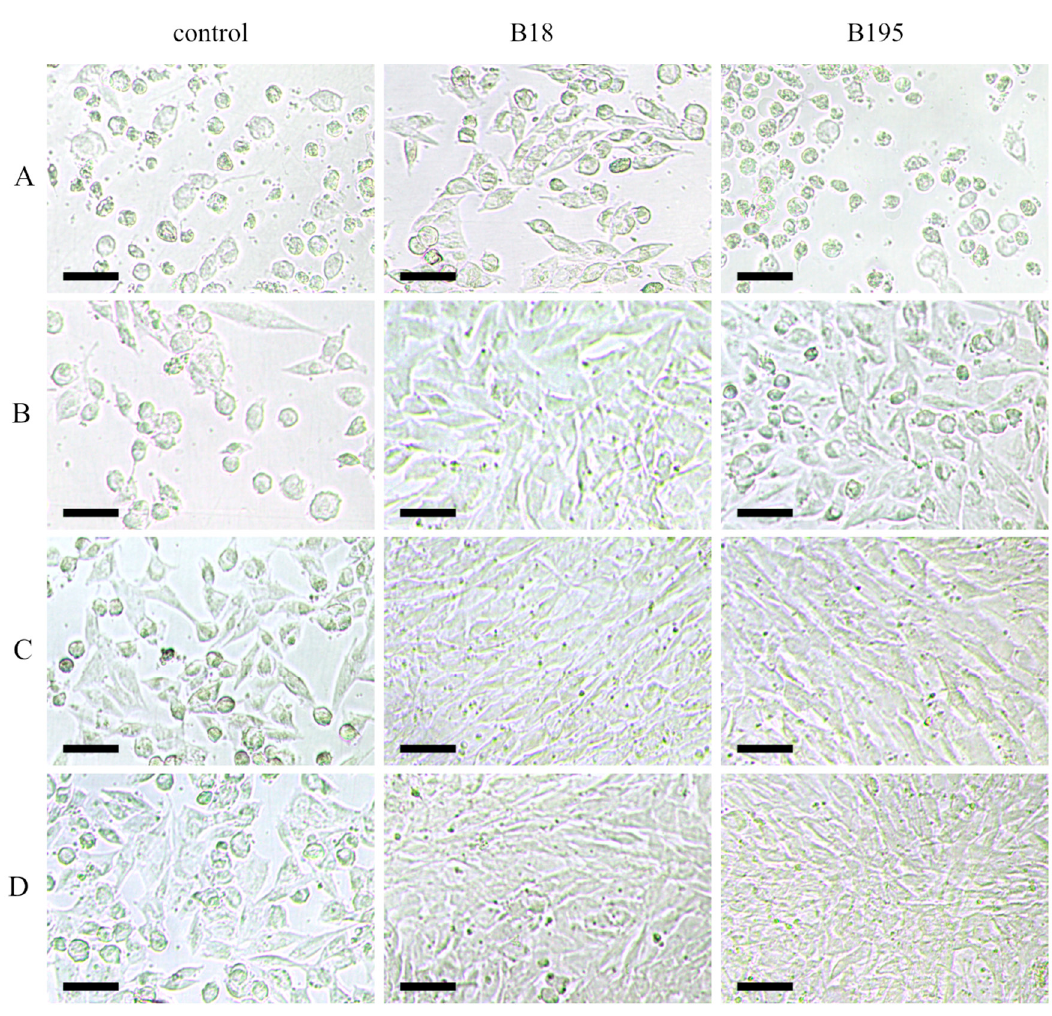
Figure 6. The FCoV stock of 2 × 10 5 TCID 50 (control A – D ) caused visible symptoms of infection in the CRFK cells, as revealed by the strong cytopathic effects. Pre-incubation of extracts B18 and B195 with the FCoV stock reduced the viral titers by ~99% and ~90%, respectively. Note the cytotoxic effects of the extracts at higher concentrations (B18 and B195, row A ), and the absence of infection in rows ( B – D) . Rows ( A – D) represent the 10-fold dilution series of the virus stocks treated with the solvent (control) or extracts B18 and B195. Scale bar: 50 µm.